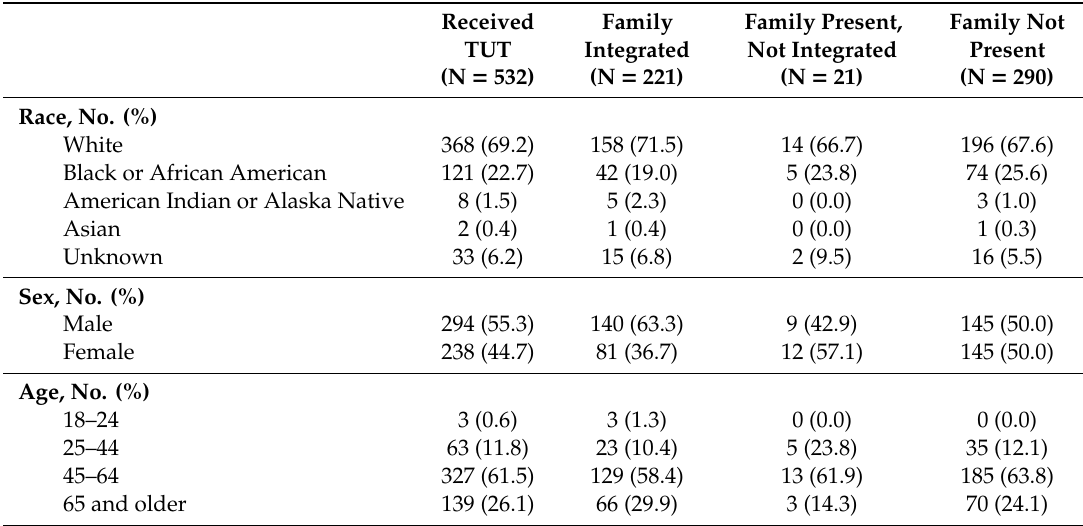
Table 1. Demographics of patients who received TUT.